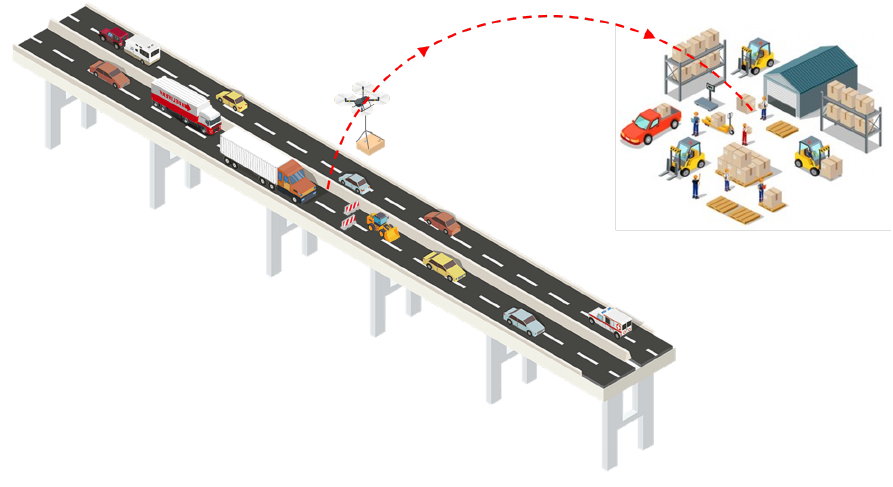
Figure 3. Example of delivery